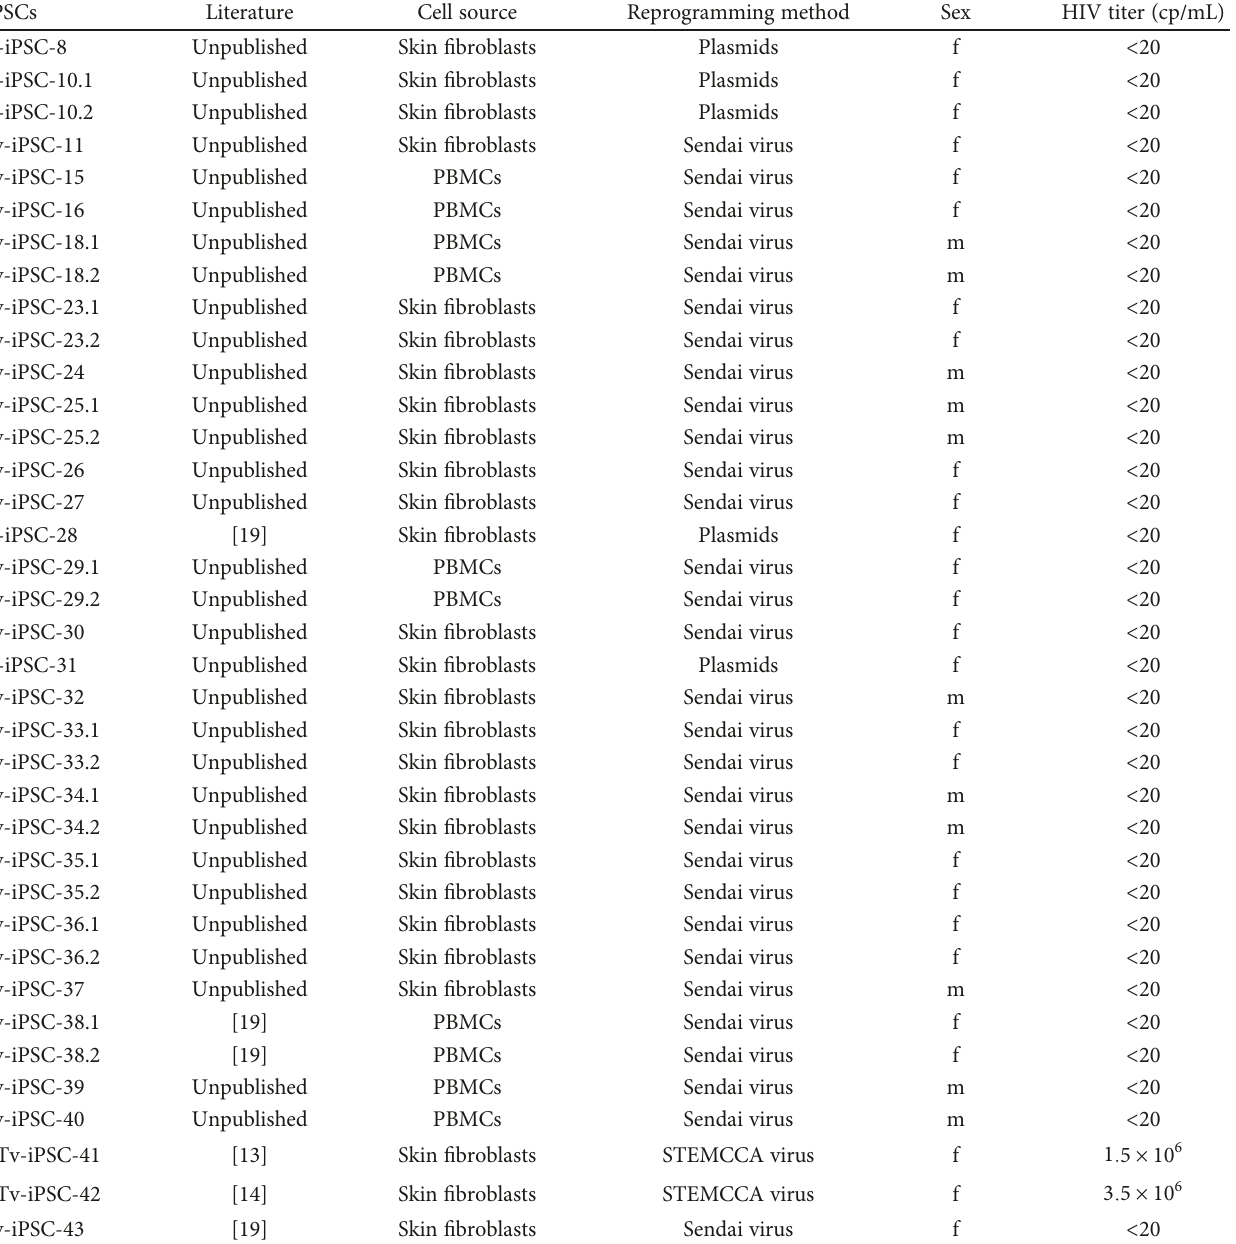
Table 3: Additional HIV-analyzed biobanked iPSC